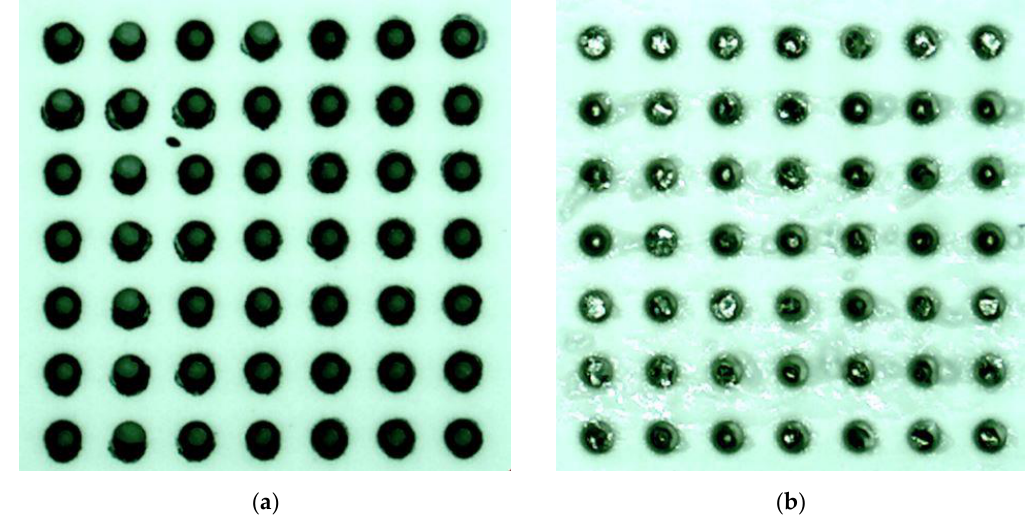
Figure 4. The carbon paste does not fill the 232 µm and 291 µm holes, however, the gelatin, the agar- agar and the two HECs fill all holes completely: ( a ) carbon paste, 232 µm holes, ( b ) gelatin, 232 µm holes.